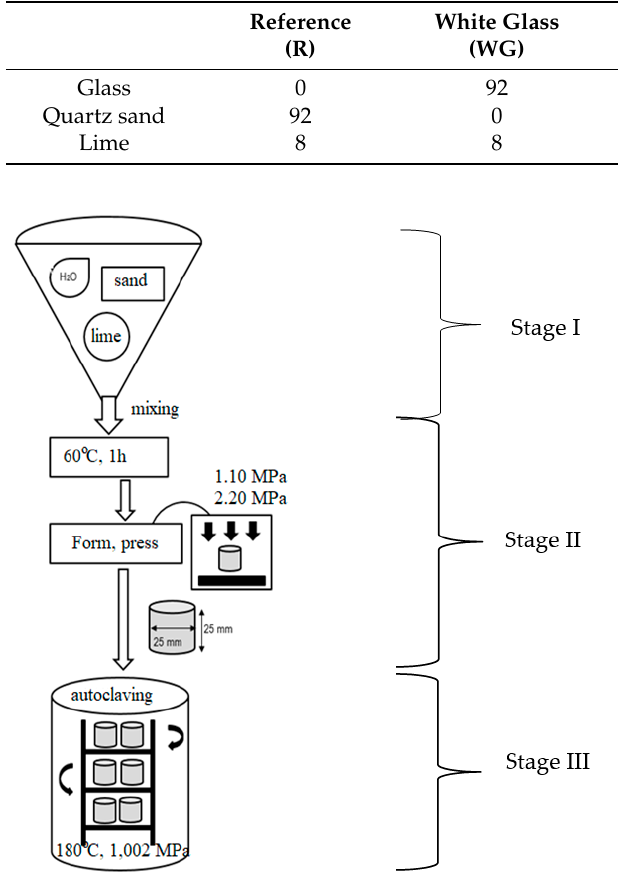
Figure 3. Scheme for the preparation of silica–lime samples involving packaging glass.